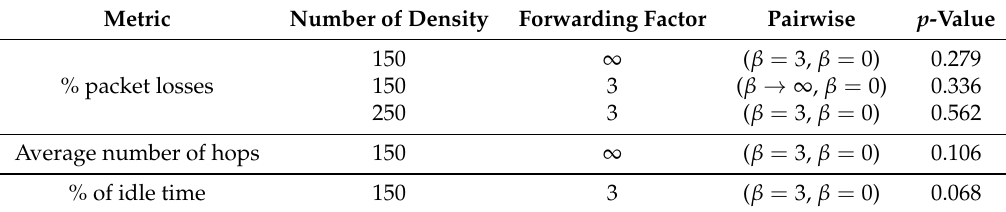
Table 7. Pairwise comparison of the performance metrics in which there is a difference among recovery techniques for the GHR protocol (i.e., p -value < 0.05 in Table 6). The table shows only the results for metrics and pairs of recovery values with the absence of statistically-significant differences (i.e., p- value ≥ 0.05).